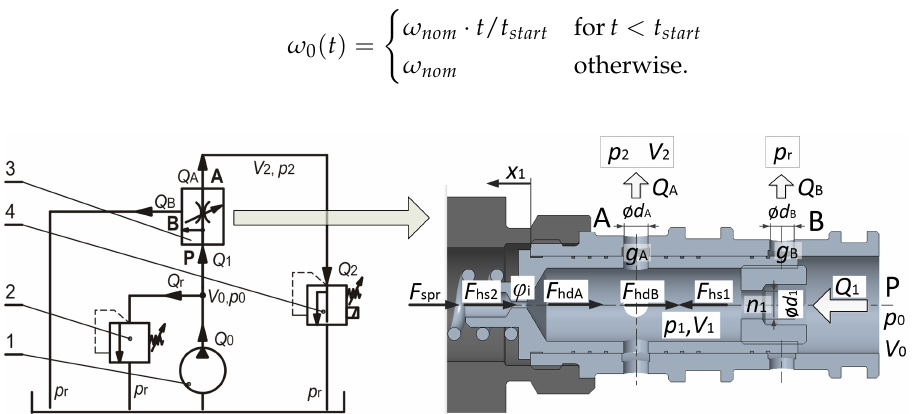
Figure 4. Hydraulic system diagram with denotations for mathematical model formulation: 1—pump, 2—safety relief valve, 3—flow control valve, 4—load line relief valve; P, A, B—connection